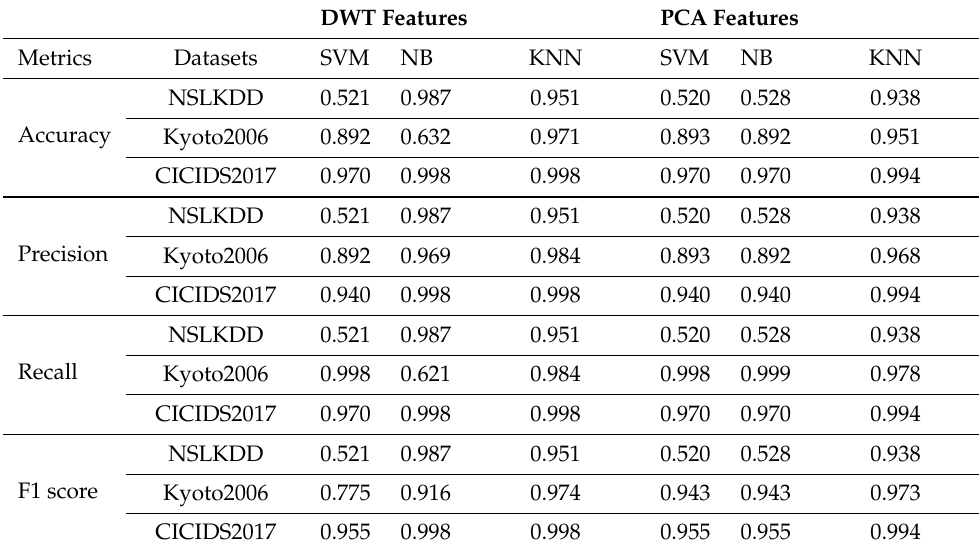
Figure 5. Detailed attack information with the DWT features (db3, α = 150 and β = 10) in the PCA projections. ( A ) NSLKDD; ( B ) Kyoto2006; ( C ) CICIDS2017. Table 1. Performance differences between all DWT features and PCA features with multiple clas- sification algorithms. For the PCA features, the first two principal components are used to run the